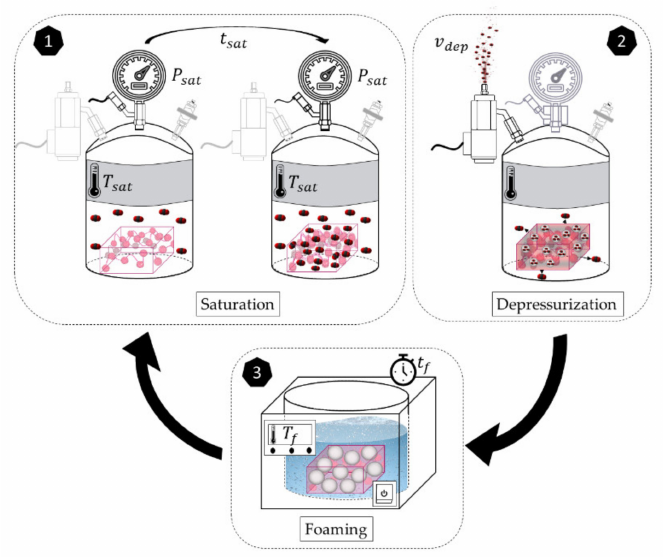
Figure 1. Scheme of the cyclic gas dissolution foaming process proposed in this